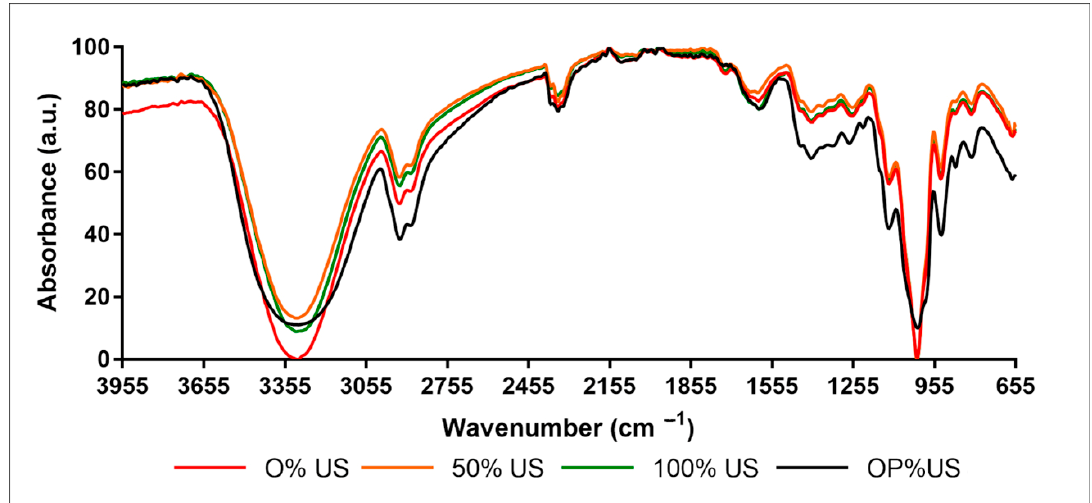
Figure 1. FTIR spectra of 0, 50, 100, and OP%US extracts.